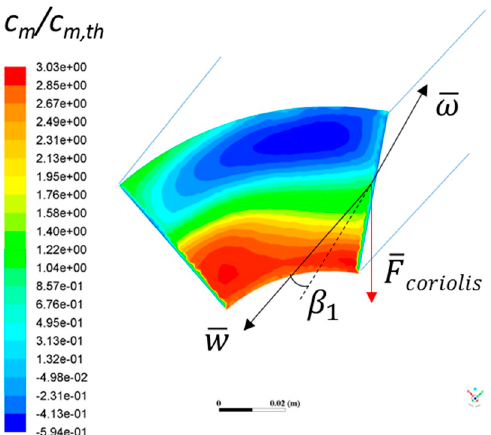
Figure 10. Contours of the meridional velocity over the theoretical value and representation of the Coriolis force and its effect at the outlet of the vane.